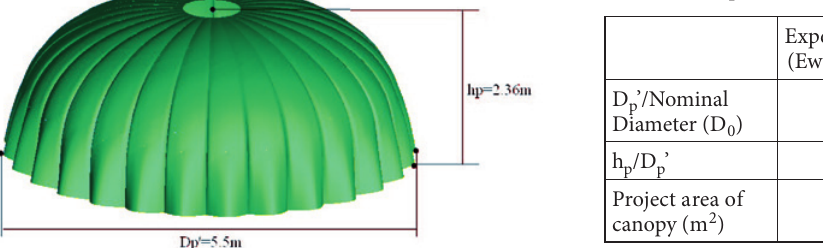
Table 6 s hows t he dra g c haracteristics. ἀ e dra